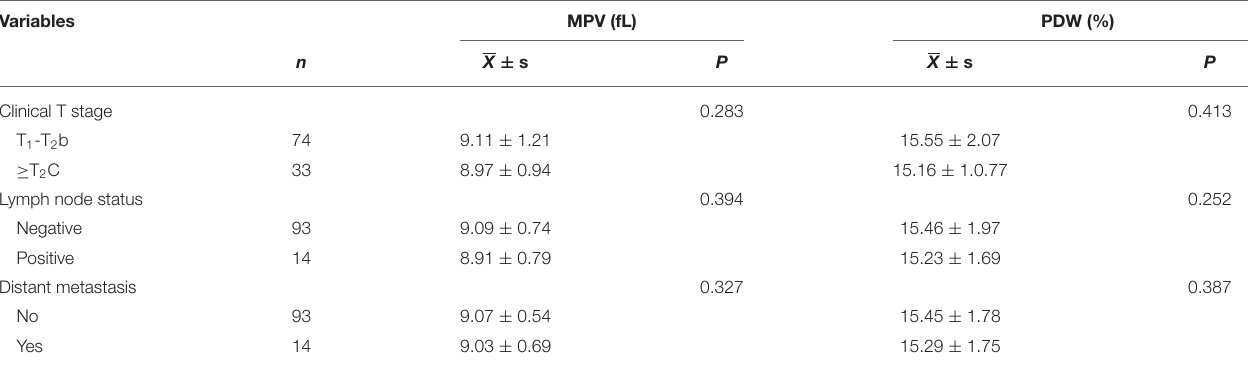
TABLE 2 | Comparisons between mean platelet volume (MPV) and tumor, nodes, and metastases (TNM) in men with PCa. Variables